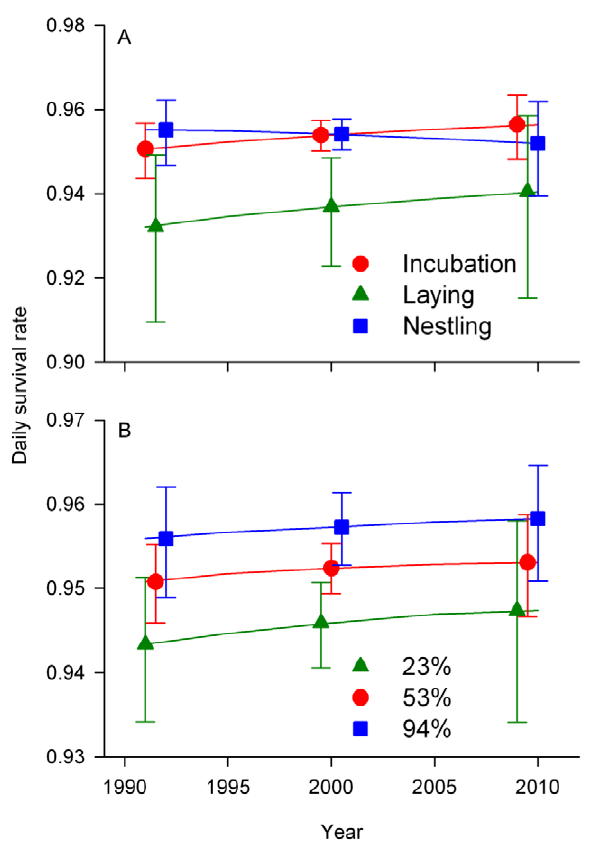
Figure 5. Nest survival by stage and forest cover. Model-based predictions of daily songbird nest survival rate by nest stage (A) and for 5%, median, and 95% observed values of forest cover (23%, 53%, and 94%, respectively; B) in Missouri, USA, 1991–2010. Predictions in (A) are for a balanced population of three songbird species at the median (53%) value of forest cover and at observed frequencies of nests in three habitat types (forest, clearcut, non-forest). Predictions in (B) are for a balanced population of three songbird species and three habitat types, with unbalanced nest stages (lay: 11%, incubation: 49%, nestling: 40%) that reflect the average time spent in each stage across species. Parasitism rates were varied across years and forest cover levels on the basis of the parasitism rate model-selection analysis. Error bars represent 95% confidence intervals and are offset for visual clarity.